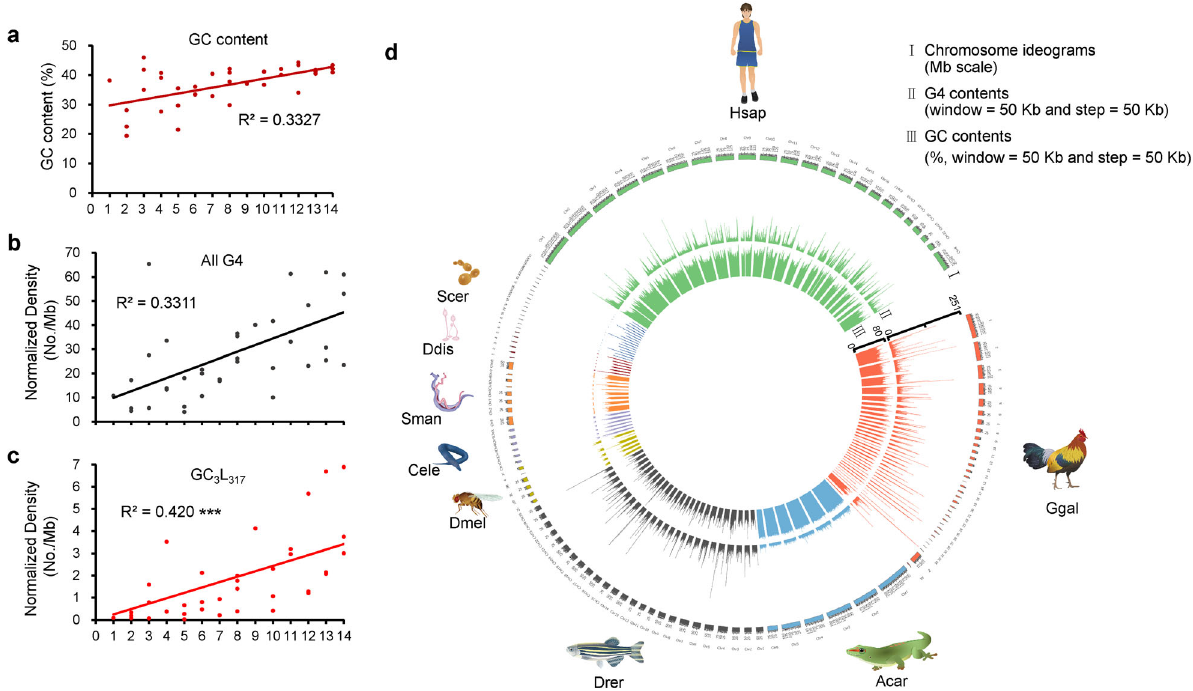
Fig. 2 GC content and chromosomal distribution of the (G/C) 3 L 1 – 7 G4 motifs in the selected species. a The GC content of the genomes of the 37 species. b , c The density of total G4 motifs and (G/C) 3 L 1 – 7 motifs, normalized over the GC contents. *** p < 0.001 by F test. n = 37 biologically independent samples. d Chromosomic distribution of the (G/C) 3 L 1 – 7 G4 motifs in nine selected species each from representing phylogenetic categories ranging from the fungus